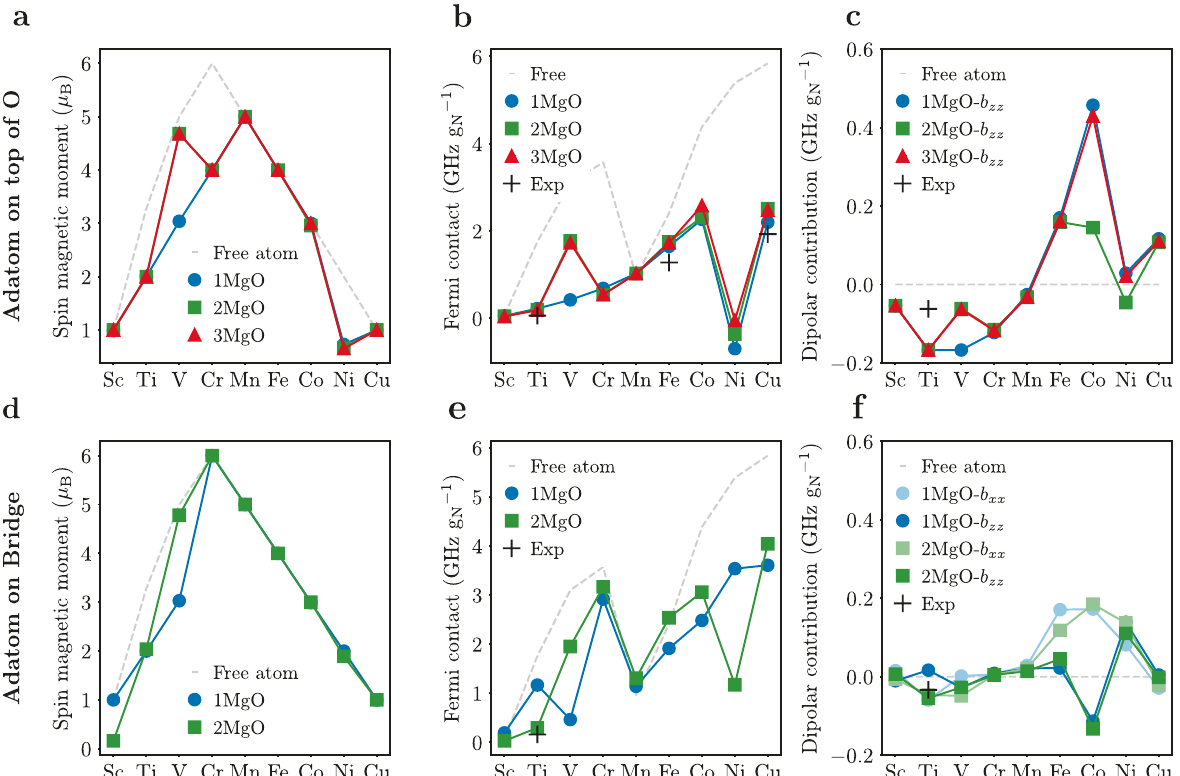
Fig. 4 Magnetic properties of adatoms on MgO ultra-thin fi lms. Adatoms placed on top of oxygen ( a – c ) and on the bridge position ( d – f ). a , d Spin magnetic moment, b , e Fermi contact and c , f dipolar contributions to the hyper fi ne interaction. The number to the left of MgO in the legend indicates the number of layers in the ultra-thin fi lm. The gray dash line represent the free-atom results. The black crosses in b , c and e , f refers to the experimental results for Fe and Ti from Ref. 35 and for Cu from Ref. 37